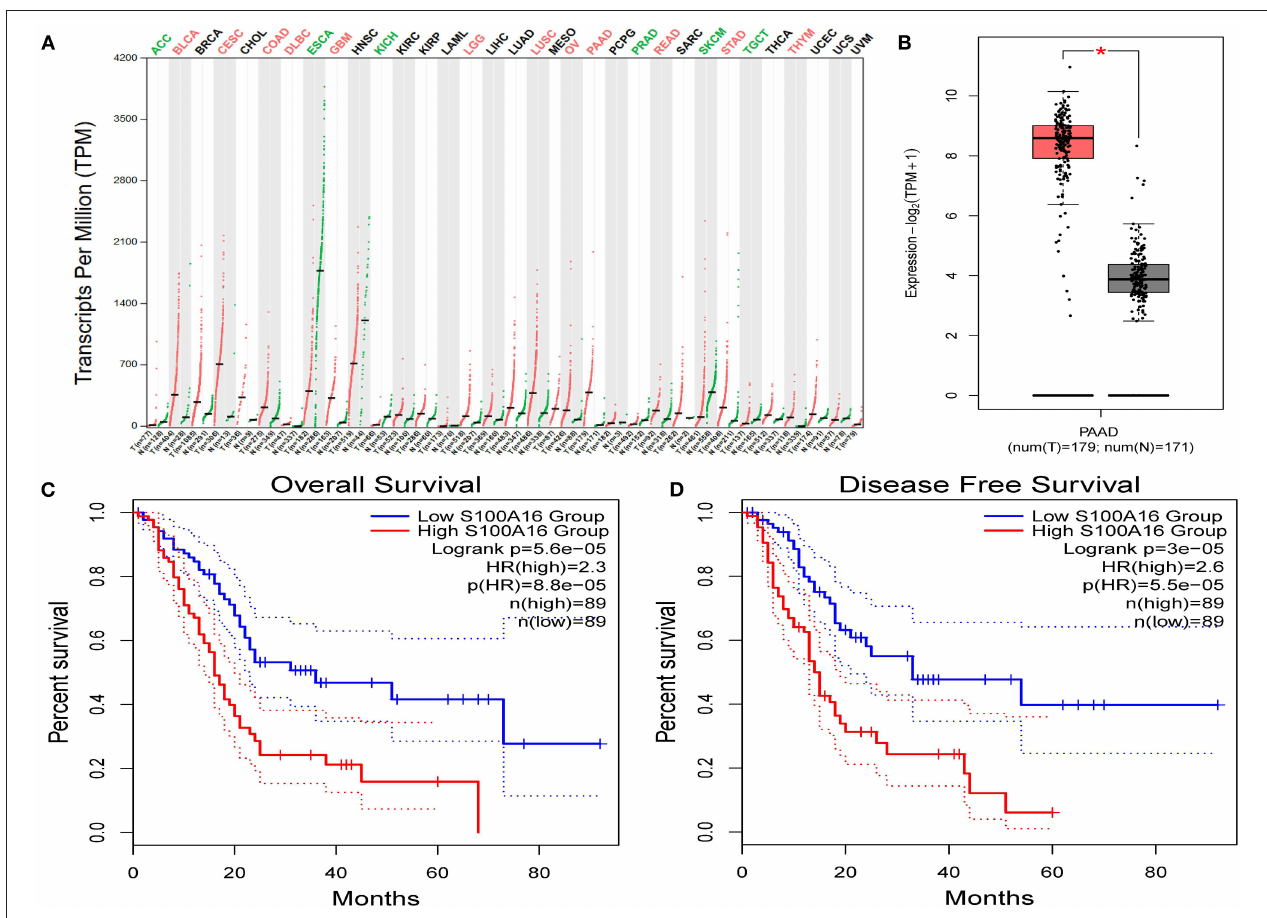
FIGURE 6 | Relationship between S100A16 expression and prognosis of PC patients based on GEPIA database. (A) S100A16 was significantly upregulated in various tumors, such as BLCA, CESC, COAD.DLBC, LGG,OV, PAAD, READ, and THYM. Expression level of S100A16 in PAAD in comparison with the normal control. * P < 0.05. (B) The relationship between S100A16 expression levels and overall, in PDAC patients as analyzed by GEPIA database. (C) The relationship between S100A16 expression levels and disease-free survival in PC patients as analyzed by GEPIA database and disease-free survival based on GEPIA database (D)